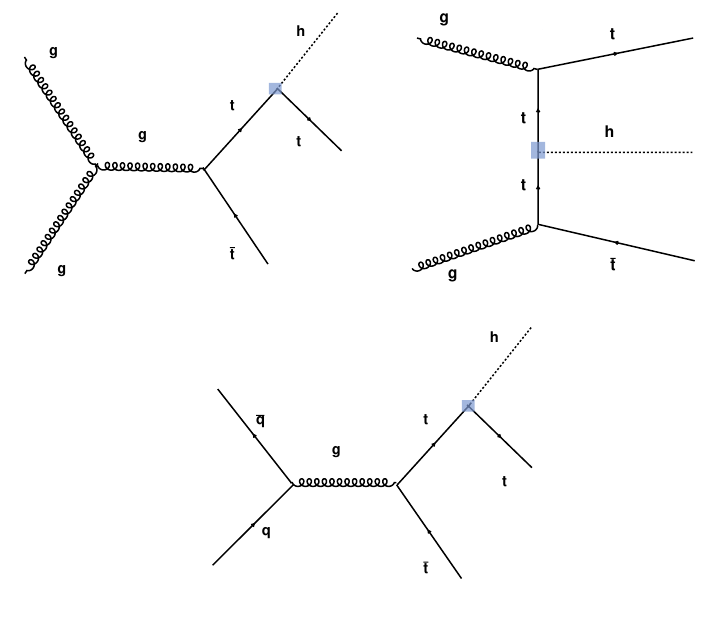
Figure 1 . Feynman diagrams contributing to t (cid:22) th production at